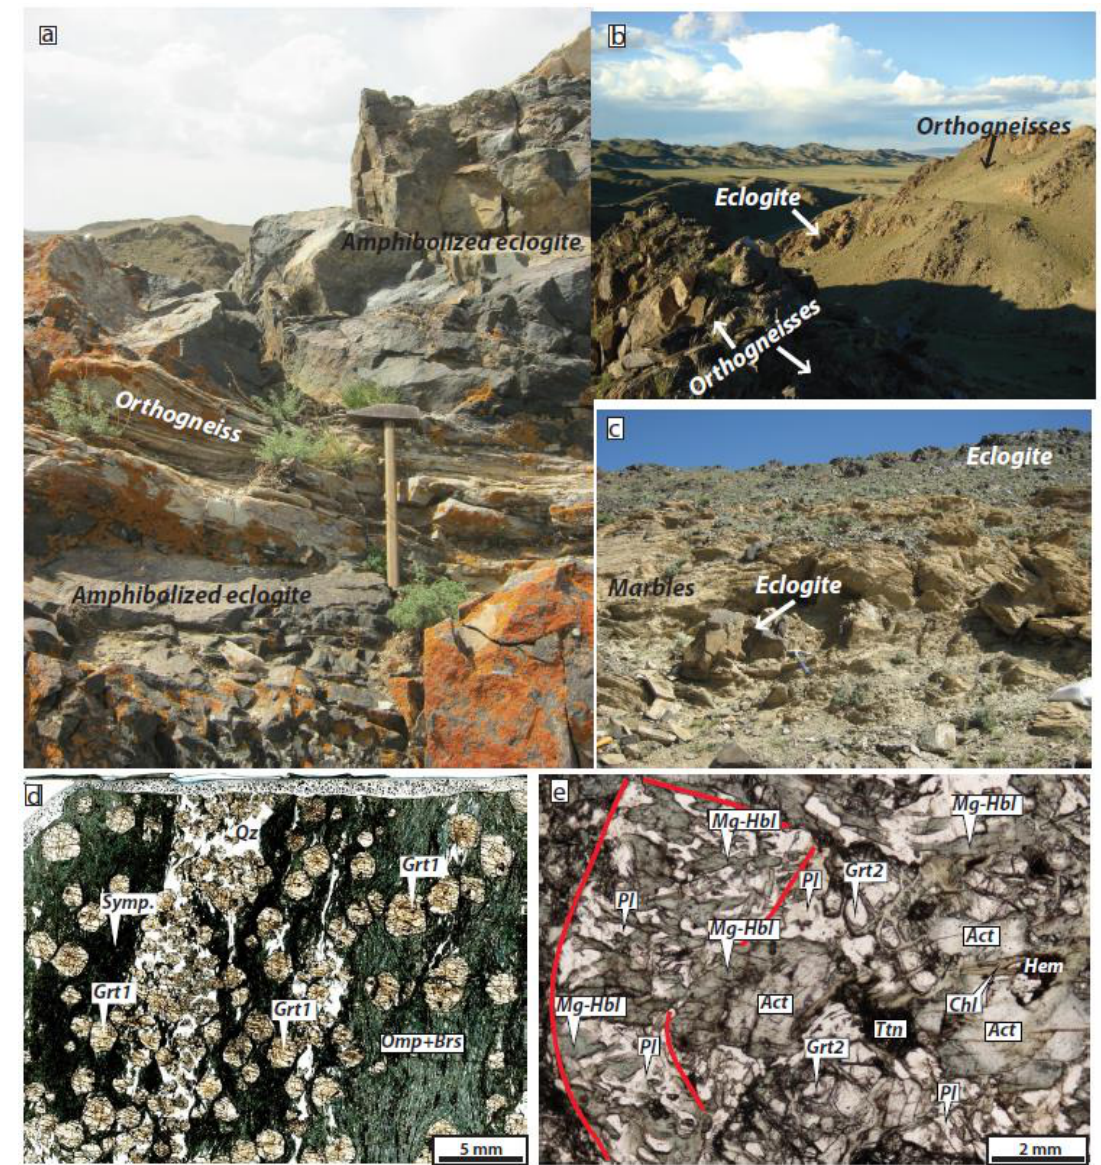
Figure 3. view of the outcrops in the Chandman district. ( a ) Orthogneiss interleaved with amphibolitized eclogite body (MG1220-1); ( b ) the orthogneiss surrounding eclogite body and ( c ) small lens of eclogite body enclosed in the marble; ( d ) Photomicrograph of the relatively fresh glaucophane-bearing eclogite (MG802) consists mainly of garnet (Grt1), omphacite, and barroisite. Compositionally different layers developed along the schistosity in the eclogite sample as composed of quartz-rich and quartz poor mafic layers; ( e ) Photomicrograph of the amphibolitized eclogites consist mainly of amphiboles (actinolite, Mg-hornblende), plagioclase, and garnet. Red lines indicate boundary zone of symplectitic assemblage consisting intergrowth of plagioclase and Mg-hornblende. Larger amphiboles have zoning with paler colored cores with greenish colored rims. Abbreviations: Symp, symplectite; Grt1, garnet1; Grt2, garnet2; Omp, omphacite; Brs, barroisite; Qz, quartz; Mg-Hbl, Mg-hornblende; Pl, plagioclase; Act, actinolite; Ttn, titanite; Hem, hematite.